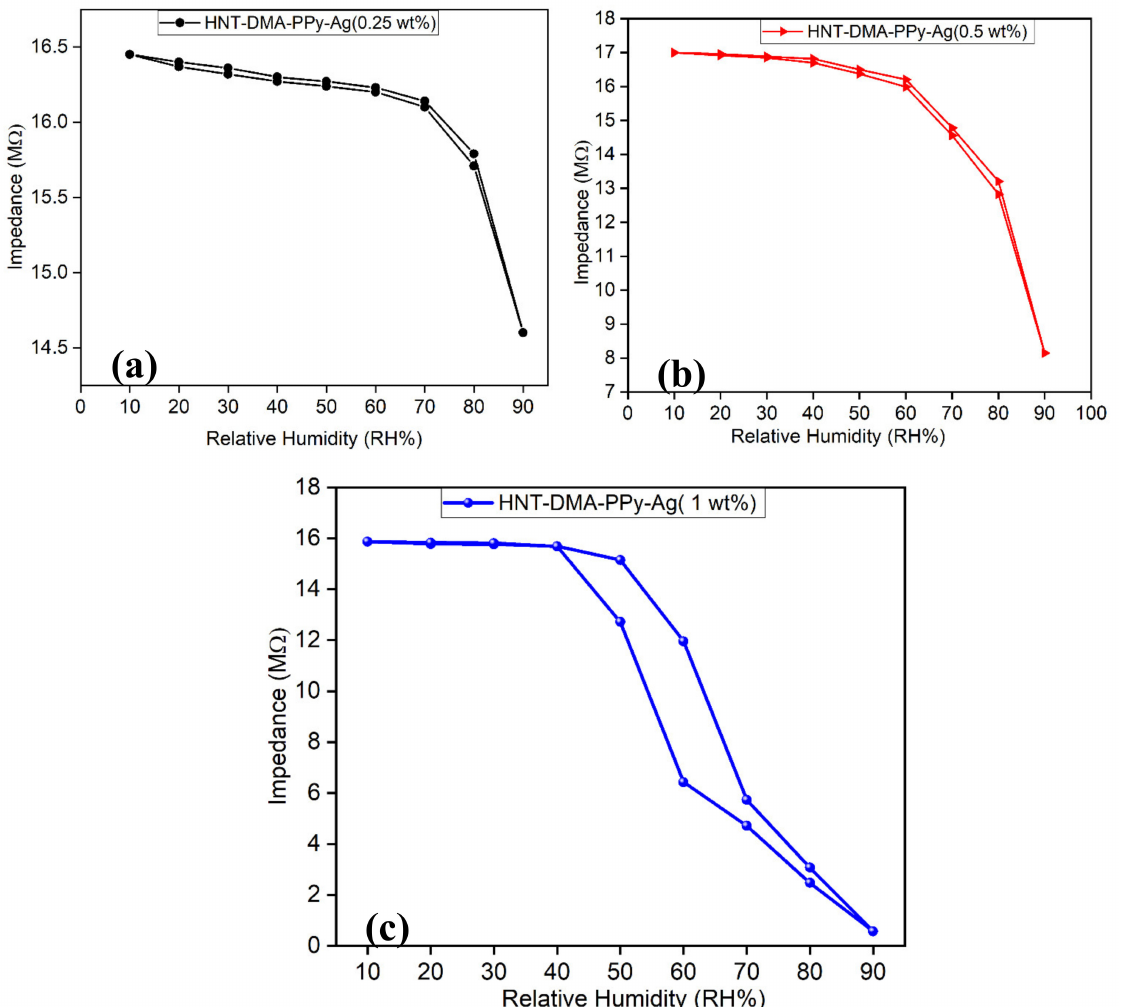
Figure 8. Impedance vs. relative humidity level for fabricated HNT-DMA-PPy@Ag nanocomposite humidity sensors operating temperature is 25 ◦ C at 10 kHz( a ) Hysteresis response of HNT-DMA-PPy@Ag (0.25 wt%) ( b ) Hysteresis response of HNT-DMA-PPy@Ag ( 0.5 wt%) ( c ) Hysteresis response of HNT-DMA-PPy@Ag (1